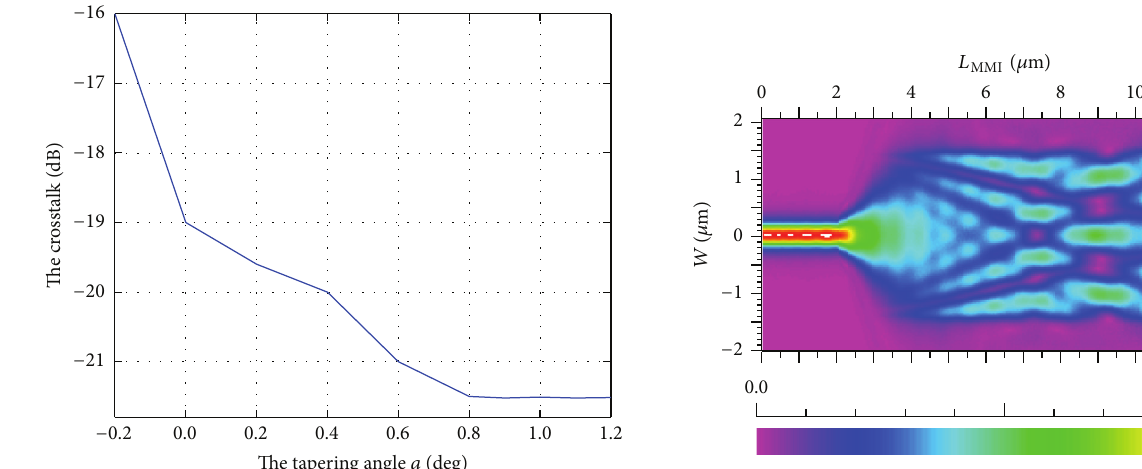
Figure 9: Spectral responses when the tapering angle 𝑎 = −0.2 ∘ , 0.6 ∘ , 0.9 ∘ .